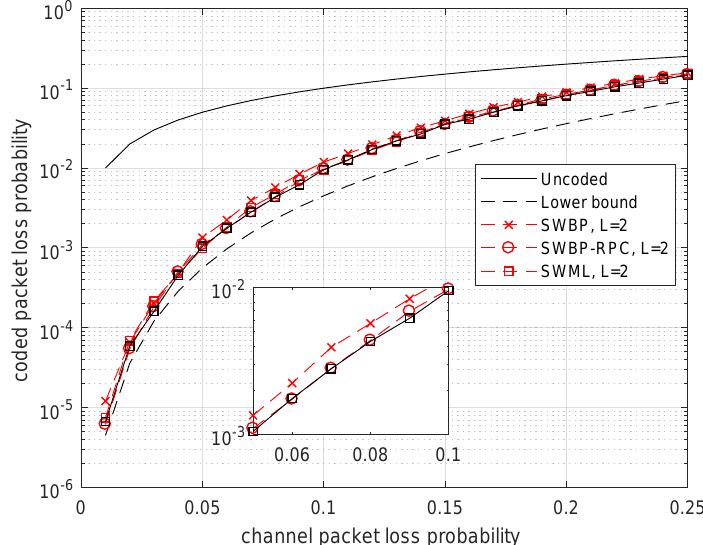
Figure 3. Comparison of SWML decoding and SWBP decoding with RPC of the binary Wyner–Ash code of rate R = 3/4.